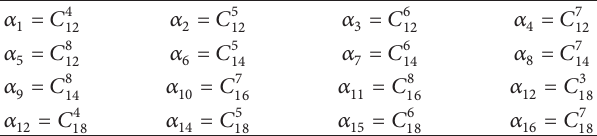
Table 1: Notation for the QFLA